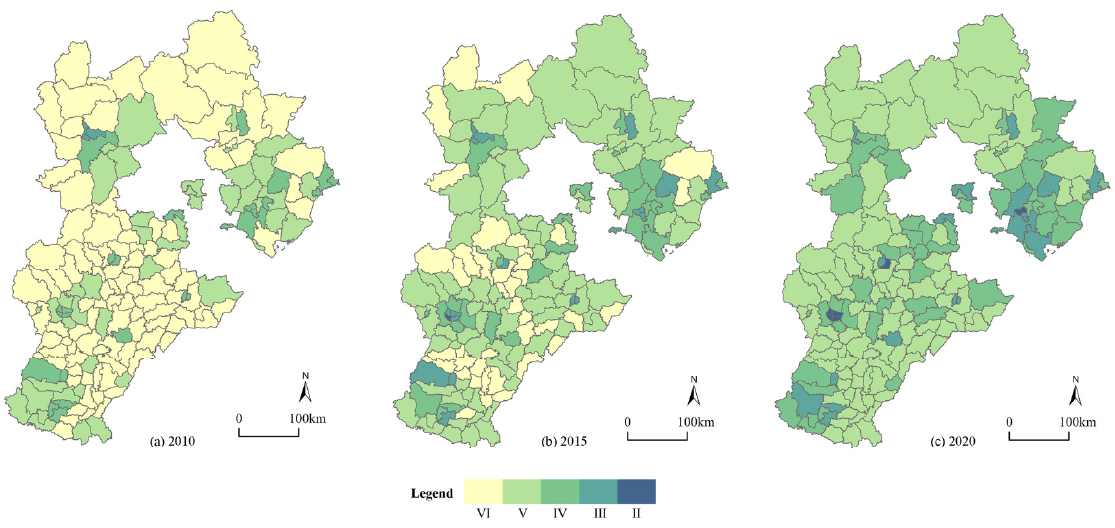
Figure 5. Spatial distribution of the coupling coordination degree between urbanization and urban resilience of 167 counties in Hebei. ( a ) CCD in 2010; ( b ) CCD in 2015; ( c ) CCD in 2020.